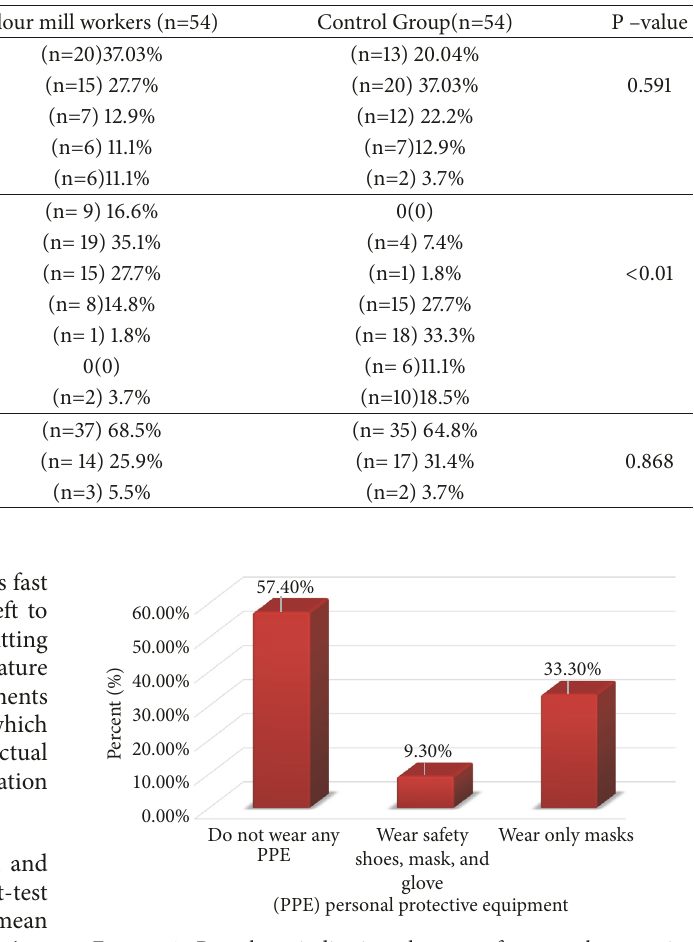
Figure 1: Bar chart indicating the use of personal protective